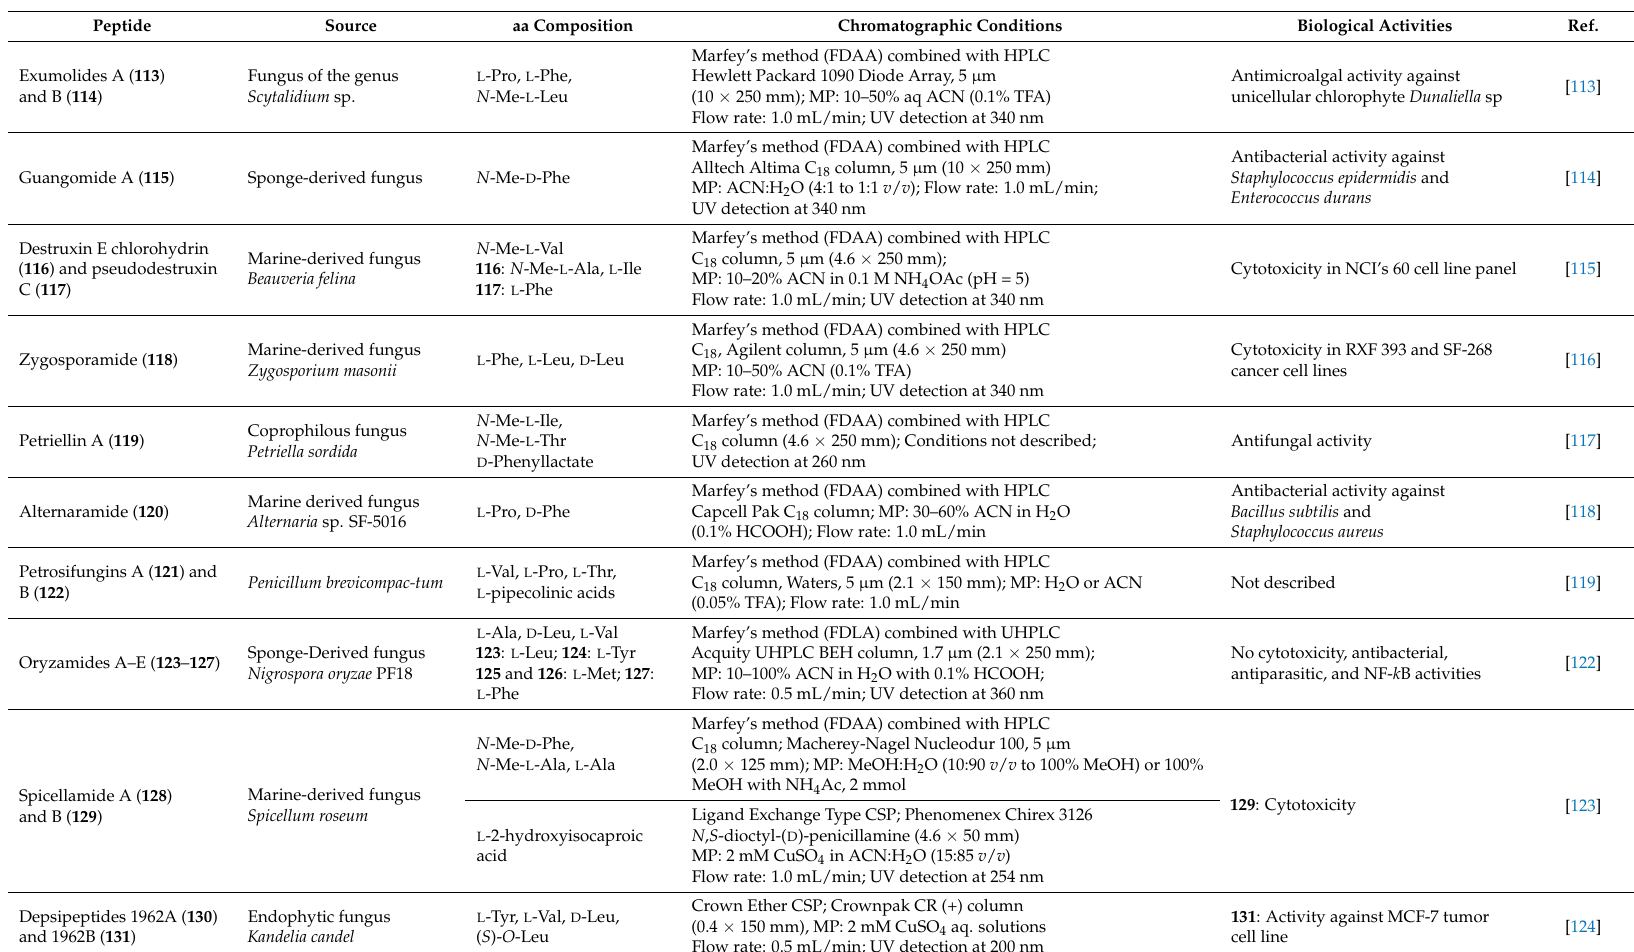
Table 5. Cyclic depsipeptides from marine-derived